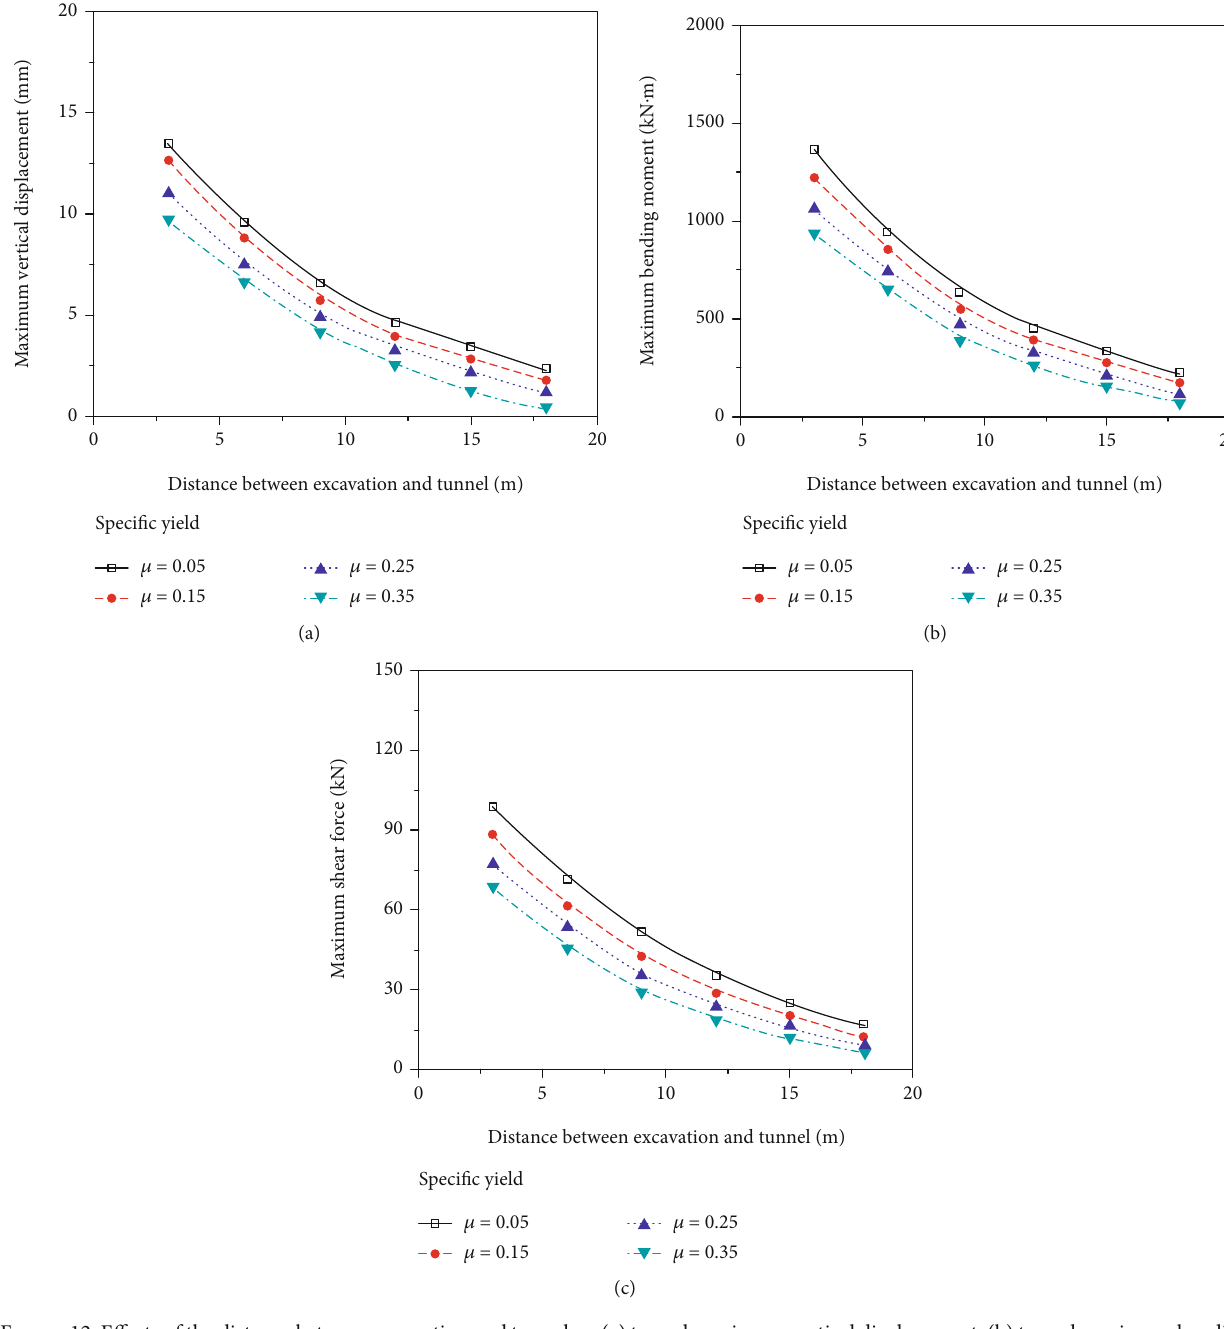
Figure 12: E ff ects of the distance between excavation and tunnel on (a) tunnel maximum vertical displacement; (b) tunnel maximum bending moment; (c) tunnel maximum shear